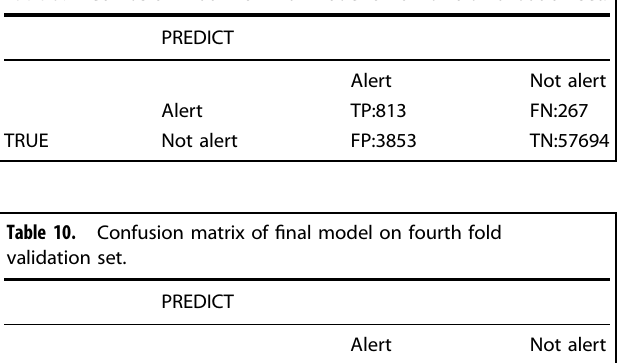
Table 9. Confusion matrix of fi nal model on third fold validation set.